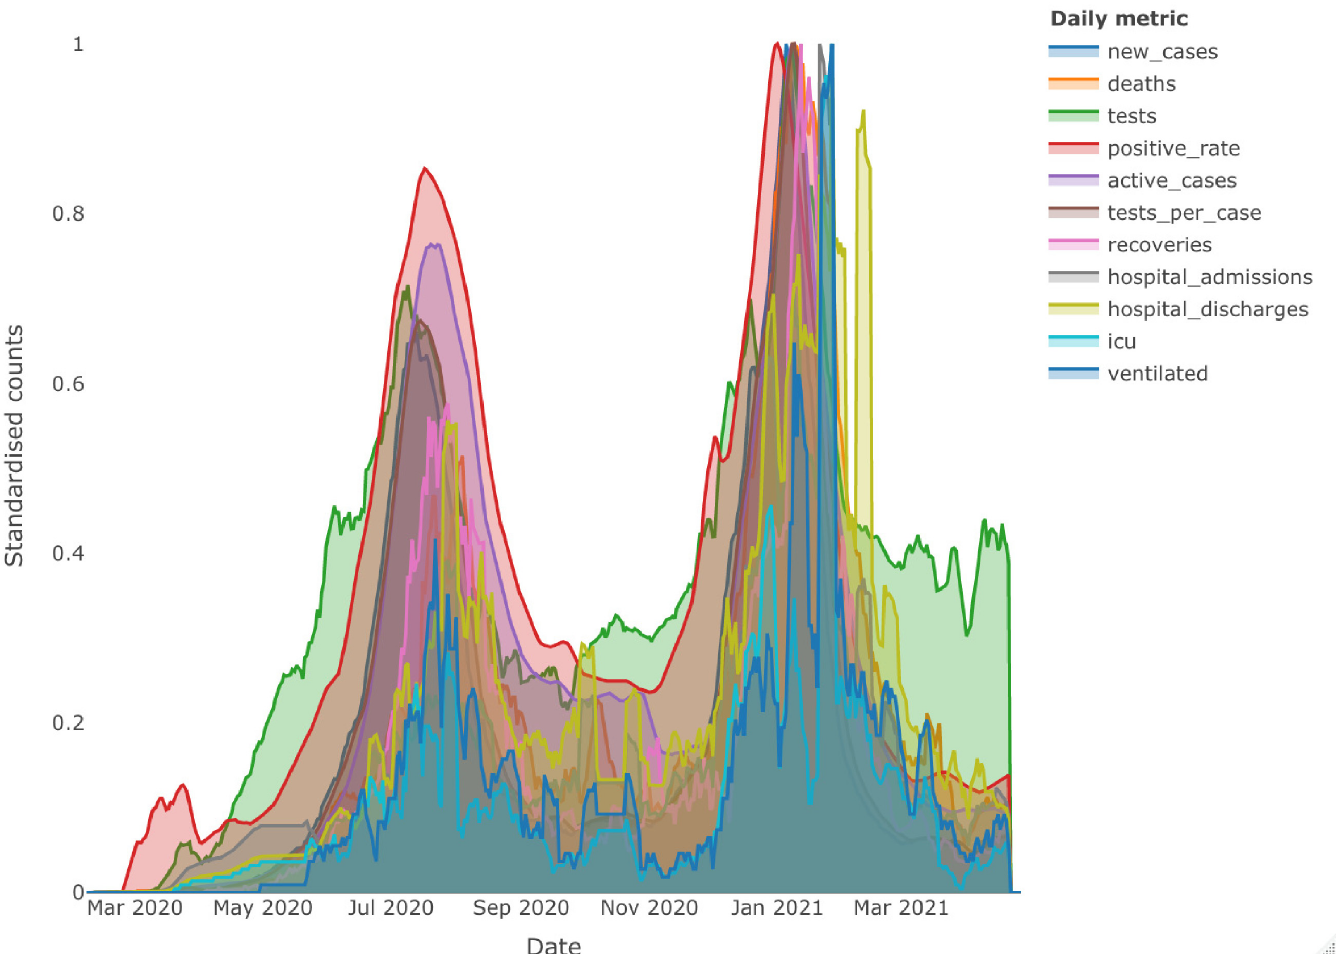
Fig 5. South African COVID-19 daily metrics over time. 7-day moving average filled area line plots with standardised counts for daily new cases; deaths; tests; positive test rate; active cases; tests per active case; recoveries; hospital admissions; hospital discharges; ICU admissions and ventilated patients.